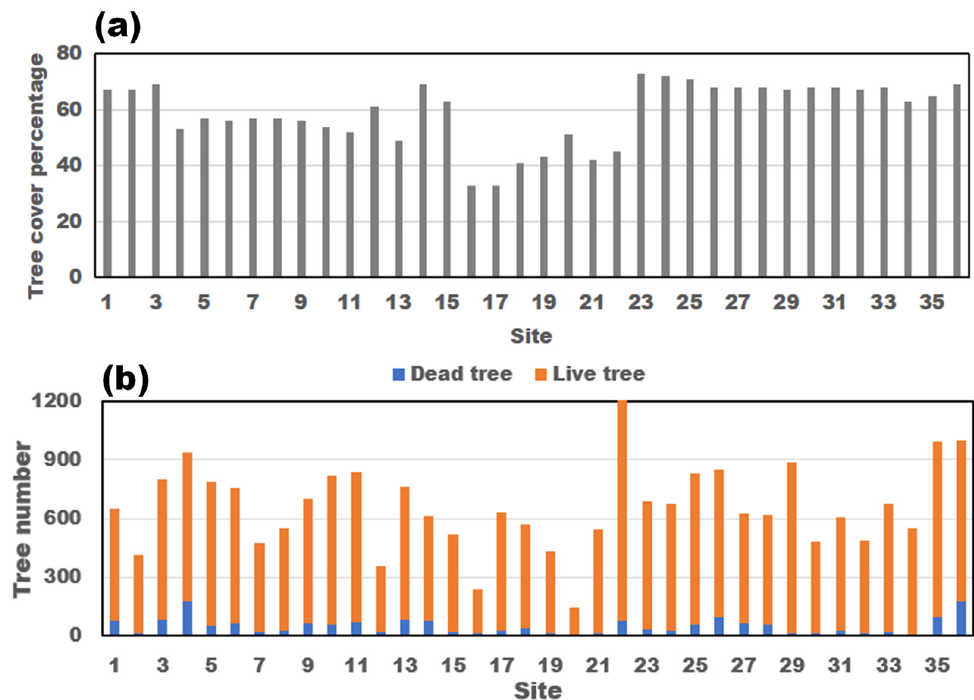
Figure 7. Tree cover percentage of MODIS pixels that we used for forest AGB estimation ( a ); the total count of live and dead trees contained in each site ( b ).